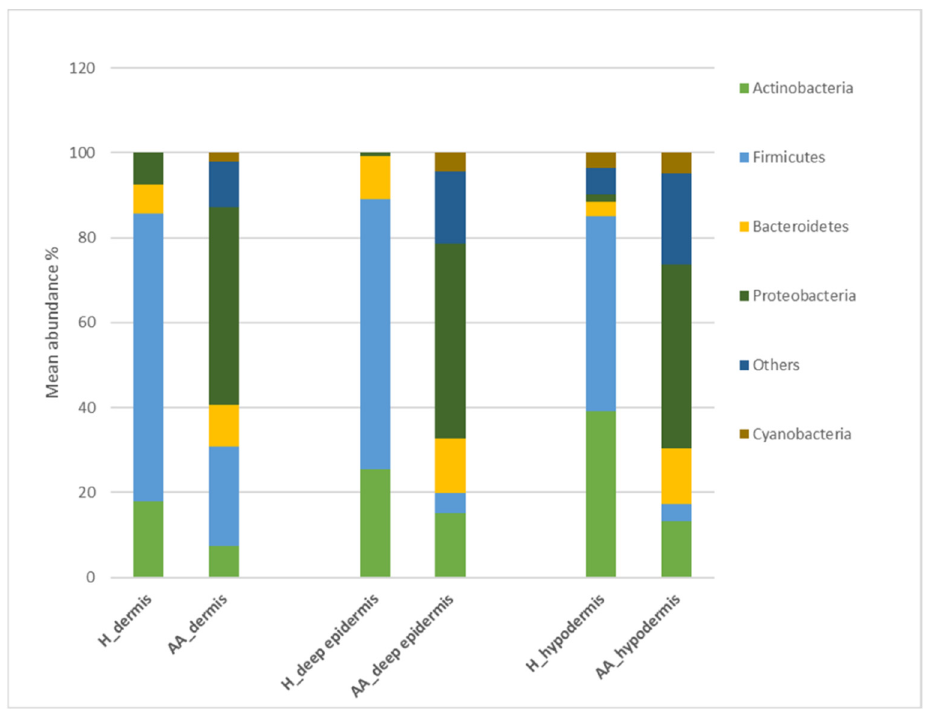
Figure 1. Bacterial profiling in control and AA subjects. Percentage of bacteria at phylum level in the healthy controls (H) and patients with alopecia areata (AA) groups. Results are presented as the percentage (%) of total sequences. Table 1. Statistically different taxa emerged between microbial taxa healthy abundances versus alopecia areata (AA) at sub-epidermal layers (deep epidermis, dermis, hypodermis). Layer Taxa Level Feature Healthy AA p -Value deep